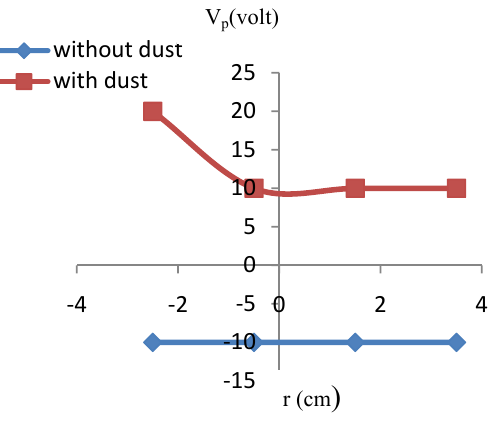
Fig. 9: Effect of al dust on radial profile of plasma potential.